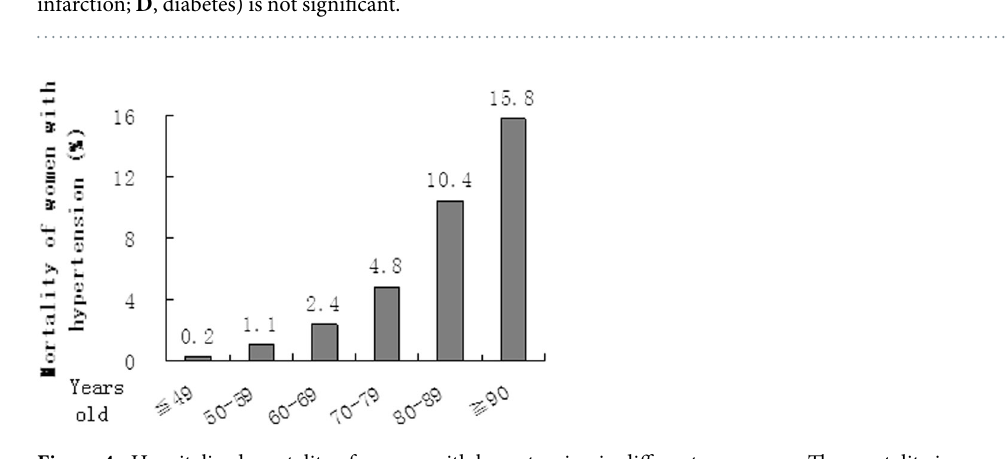
Figure 4. Hospitalized mortality of women with hypertension in different age groups. The mortality increases with